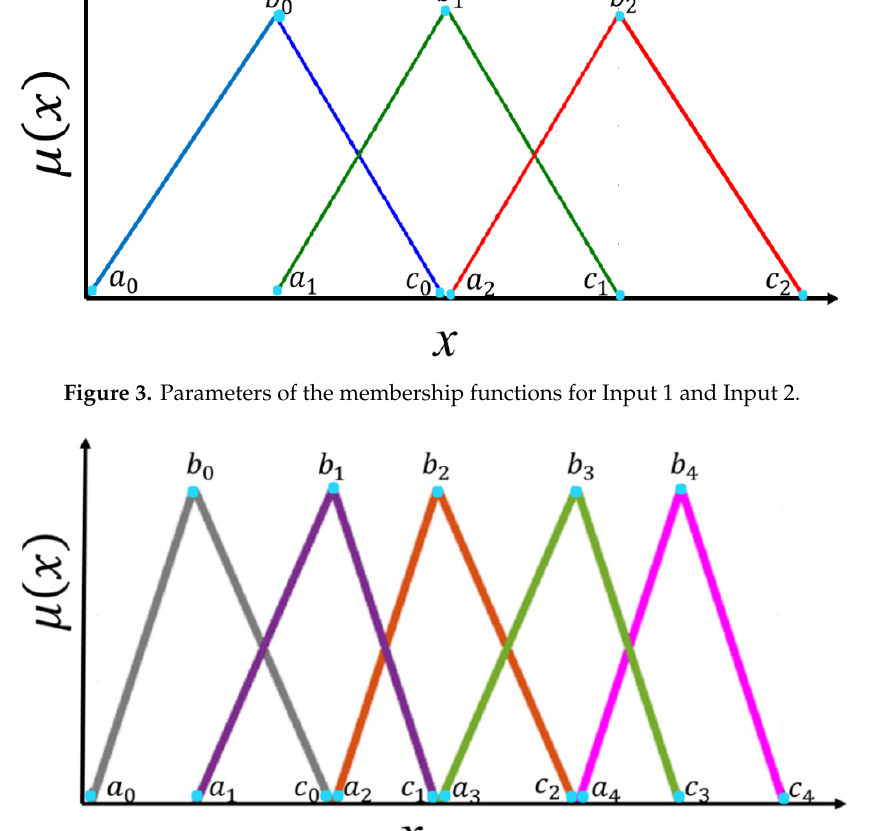
Figure 4. Parameters of the membership functions of the Output 1 and Output 2.